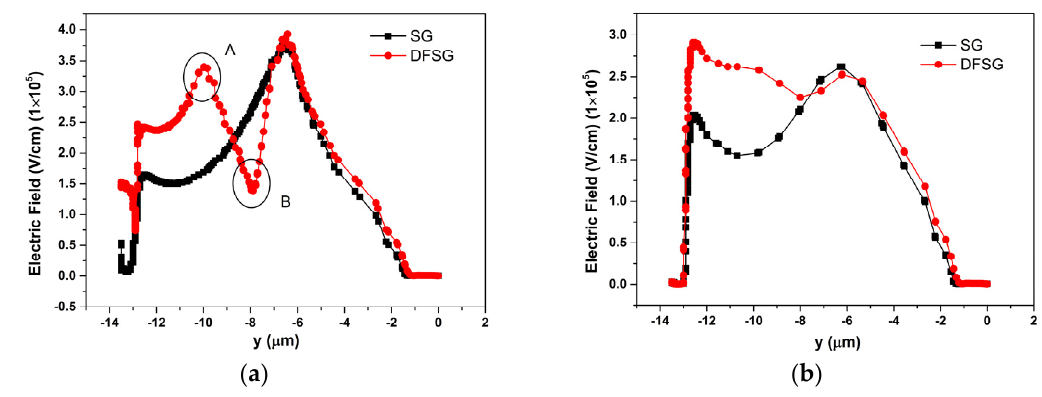
Figure 3. Electric field distributions comparing the ( a ) surface of the trench and ( b ) middle of the drift area for SGRSO and DFSGRSO UMOSFETs with the same n-drift area doping concentration.